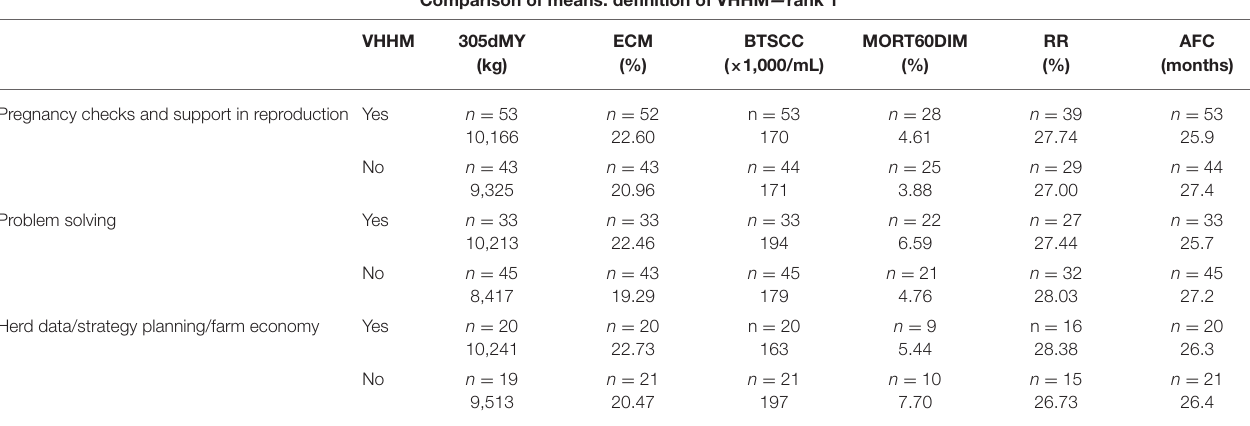
TABLE 4 | Descriptive data of relative importance of subjective definition of